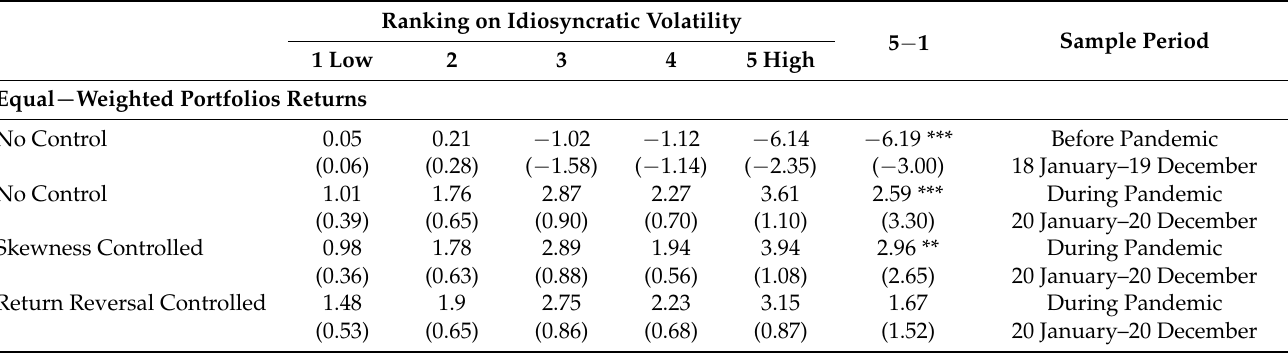
Table 1. Portfolio analysis for equal-weighted portfolios. Ranking on Idiosyncratic